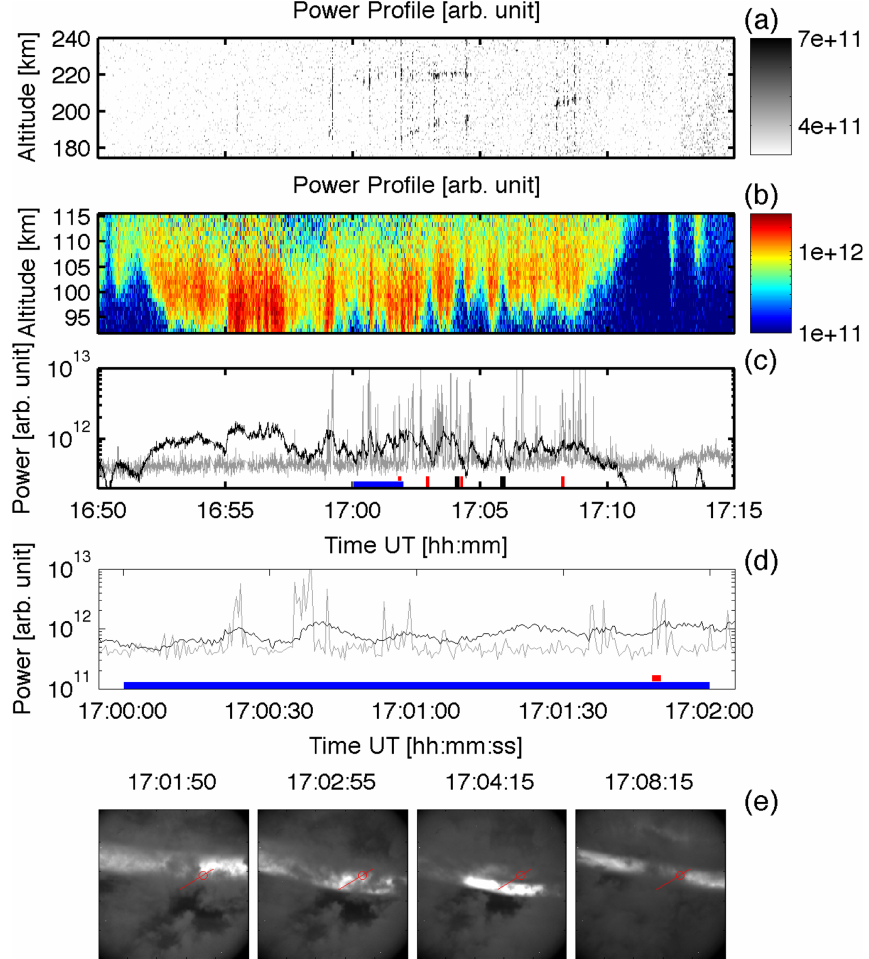
Fig. 2. Backscattered radar power from the lower F region and the lower E region are shown in (a) and (b) respectively. (c) Shows the mean backscattered power from these two regions, where the black line is the mean for the lower E region and the gray line the peak power from F region. The blue marker indicates the detail shown in (d) . (e) Four images taken with the Skibotn ALIS camera are shown. The red line indicates the radar beam from 90 to 250km with the red circle corresponding to an altitude of 100km. Indicators in (c) and (d) mark times of shown optical data (red) and radar spectra